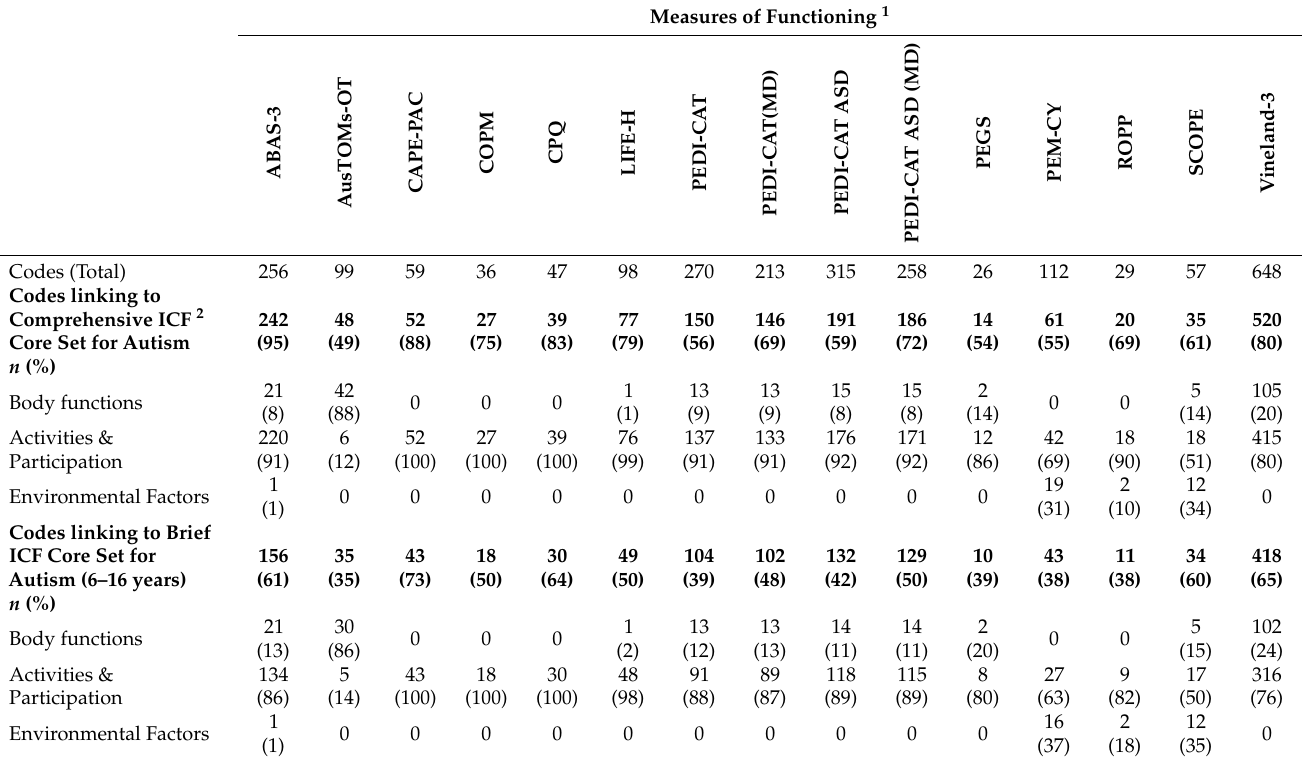
Table 6. Percentage of total codes linking to the International Classification of Functioning, Disability and Health Core Sets [20] for Autism covered by measures of functioning.